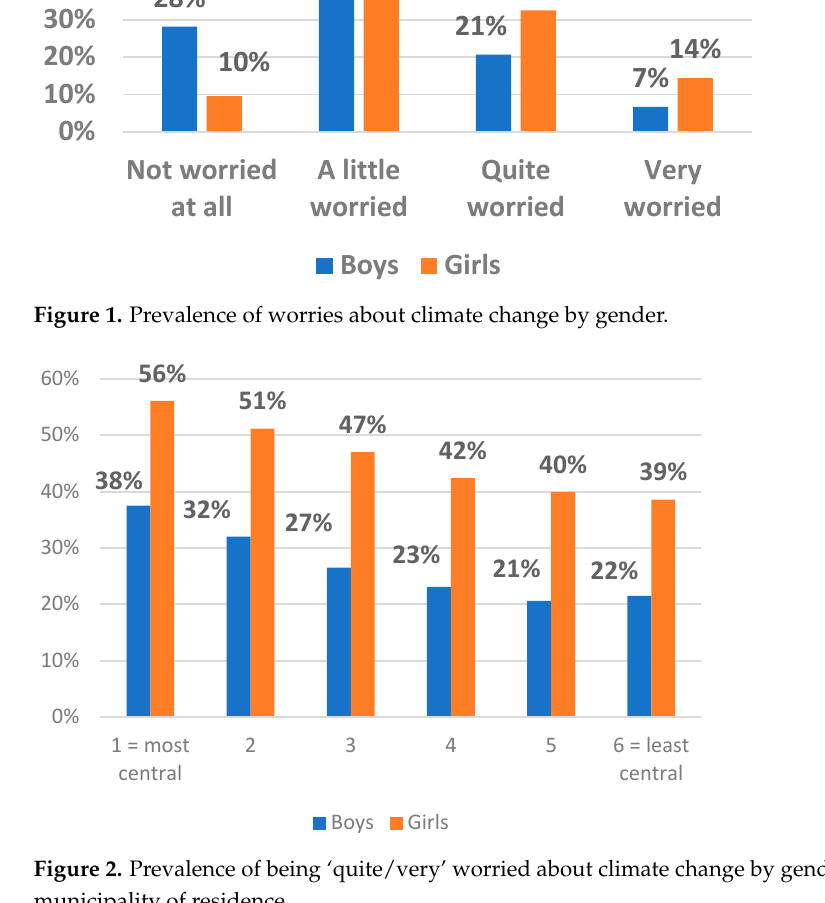
Figure 2. Prevalence of being ‘quite/very’ worried about climate change by gender and centrality of municipality of residence.